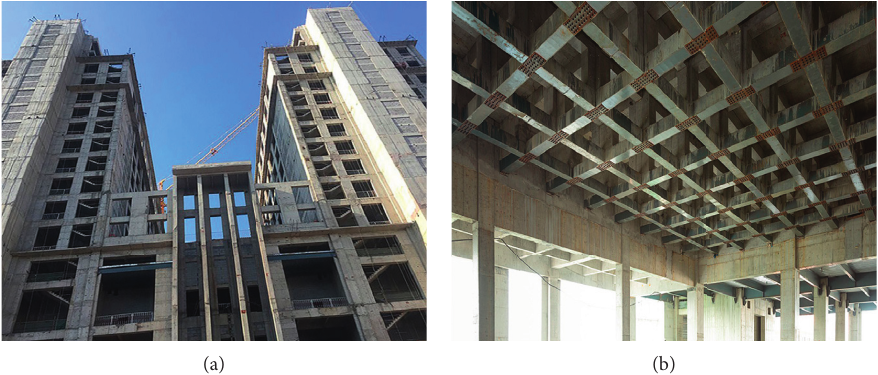
Figure 2: Photos of the tested building: (a) overview of the building; (b) on-site photo of the CHW slab system.